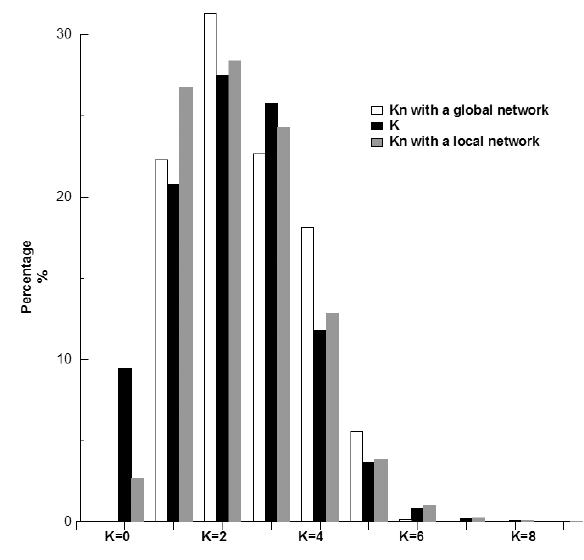
Figure 3. Comparison between the frequency distribution of Kn obtained through a local network (grey bar) and another Kn ob- tained with a global network (white bar), and also K real frequency distribution in LIV (black bar).